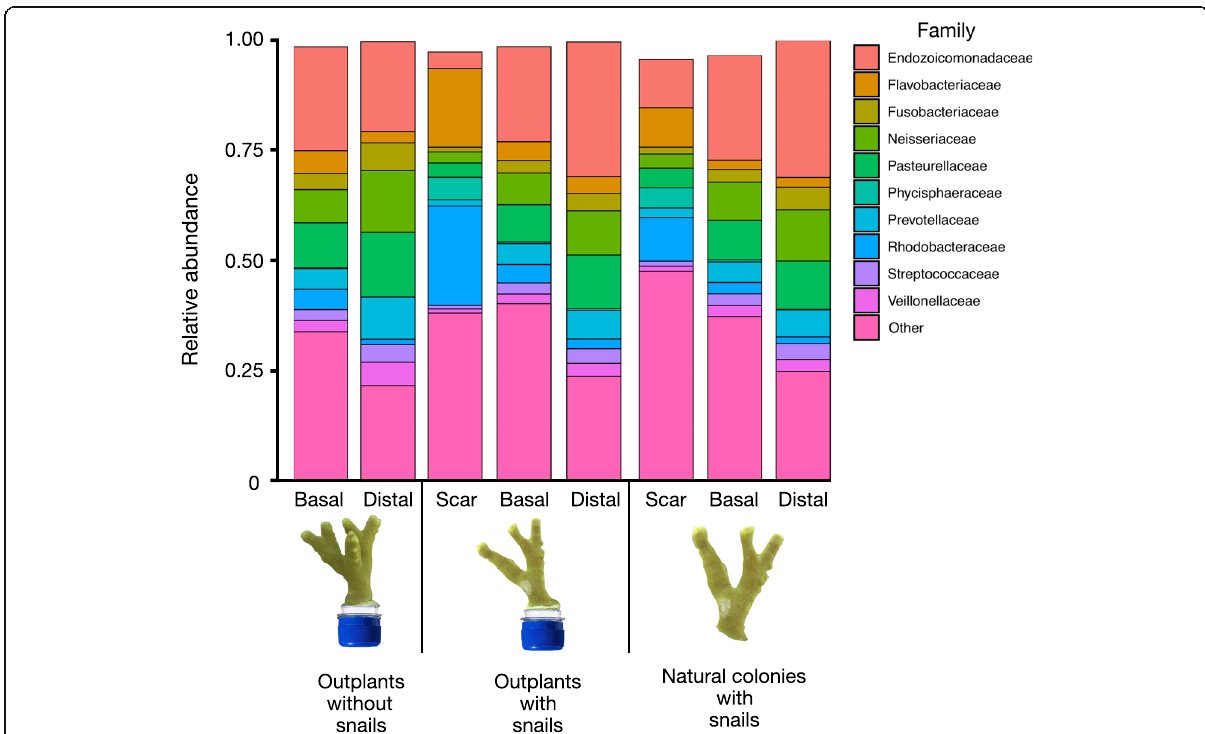
Fig. 2 Average microbial community composition. Data rarefied to 8013 sequences per sample for P. cylindrica outplants without snails (left, n = 8 [Basal], 7 [Distal]) or with snails (center, n = 43 [Scar], 36 [Basal], 39 [Distal]), and natural colonies with snails (right, n = 15 [Scar], 13 [Basal], 12 [Distal]). Taxa are grouped by family, with the ten most abundant families depicted separately. All other families were pooled and